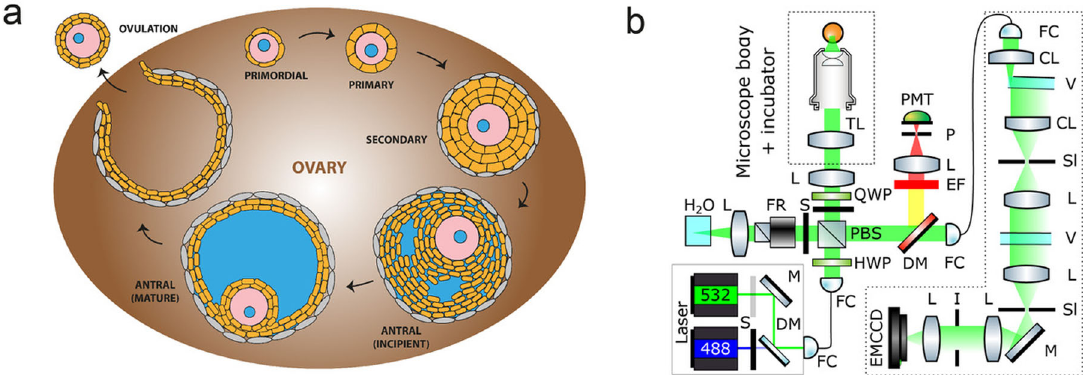
Fig. 1 Characterizing mechanical properties of ovaries ex vivo with Brillouin microscopy. a Schematic of the developmental cycle of follicles during mouse folliculogenesis. A follicle consists of the oocyte (pink) with its nucleus (blue), surrounded by the somatic cells (orange) and theca cells (gray). The oocyte grows in size during transition to secondary follicle stage, followed by the emergence of fl uid- fi lled lumen (blue) in the antral follicle stage. The oocyte is eventually released during ovulation, and upon fertilization undergoes embryo development. The interstitial tissues of the ovaries comprise of stromal cells, extracellular matrix, and vasculature. b Schematic of the confocal Brillouin imaging setup. L = lens, TL = tube lens, PMT = photomultiplier, P = pinhole, EF = emission fi lter, DM = dichroic mirror, FC = fi ber coupler/collimator, QWP = quarter waveplate, HWP = half waveplate, PBS = polarizing beam splitter, S = shutter, FR = Faraday rotator, CL = cylindrical lens, V = VIPA, Sl = adjustable slit, V = VIPA, I =